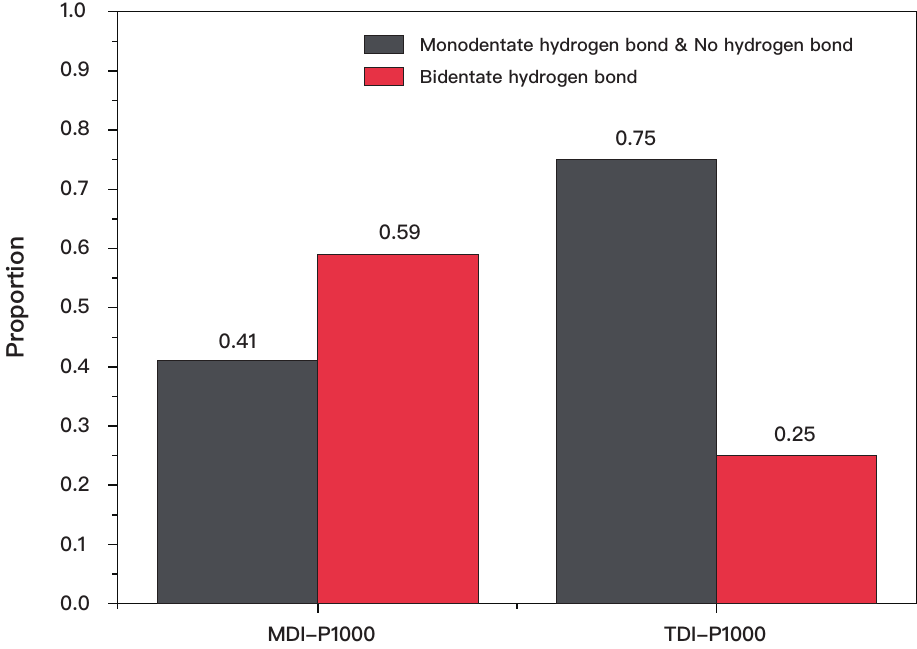
Figure 3. Comparison of bonds in MDI-P1000 and